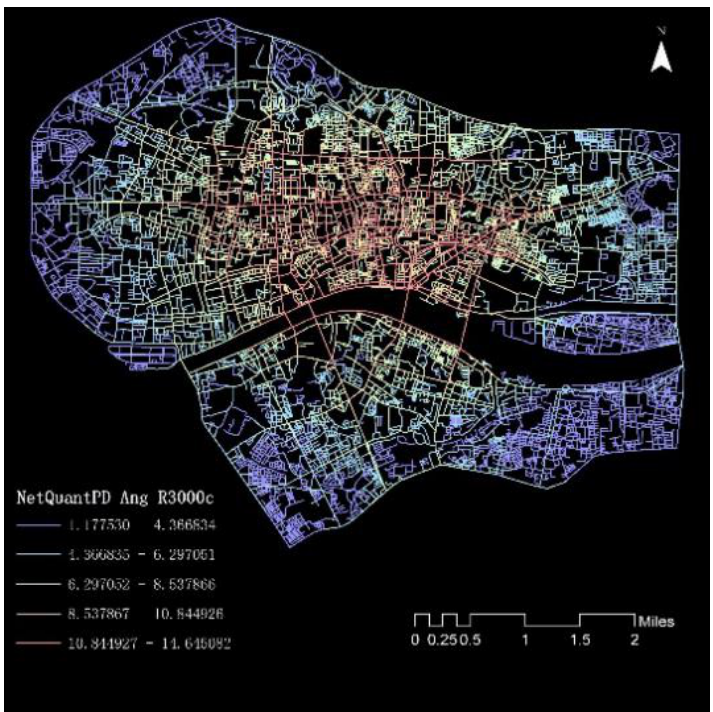
Fig. 8 The regional closeness of 3000m radius